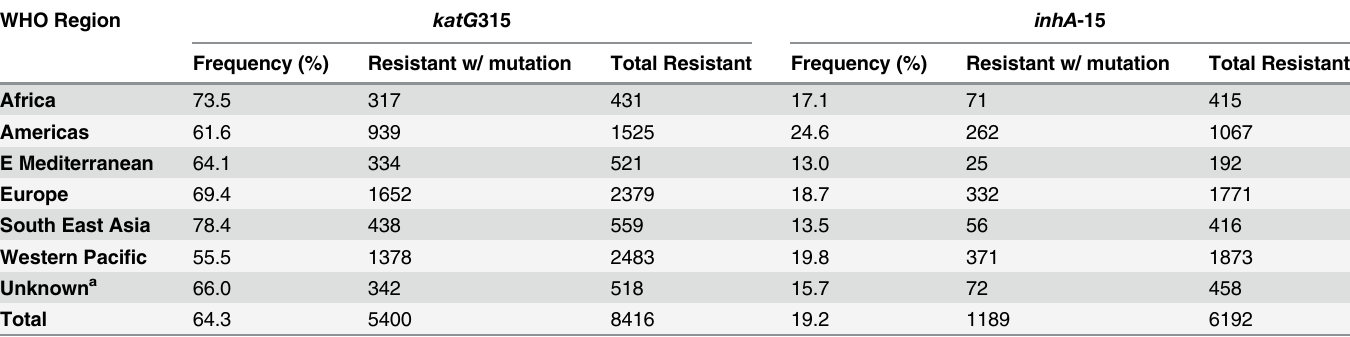
Table 3. Regional distribution of the individual frequencies for katG 315 and inhA -15. WHO